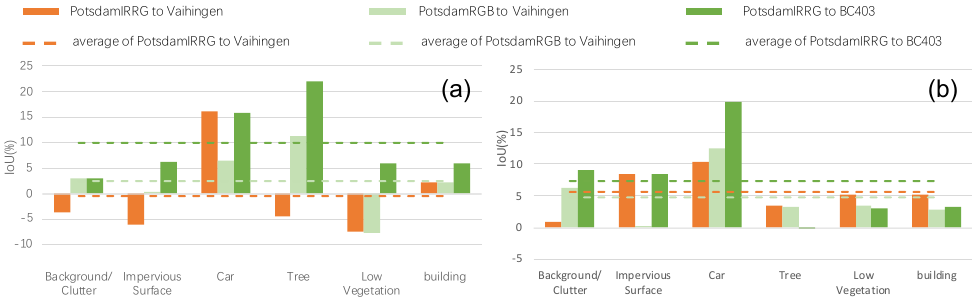
Figure 9. The length of cars in Potsdam ( a ) and Vaihingen ( b ) measured by pixel. The number in the figure represents the pixel length of the adjacent car.